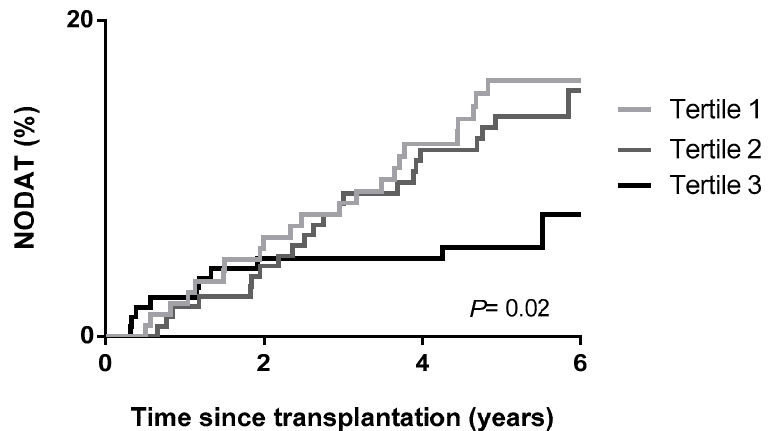
Figure 1. Kaplan–Meier curves for NODAT according to tertiles of plasma MDA concentration in RTR. Tertile 1: <2.15 µ mol/L; Tertile 2: 2.15–3.09 µ mol/L; Tertile 3: >3.09 µ mol/L. p value was calculated by Log-rank (Mantel cox) test. Table 2. Plasma MDA concentration and new-onset diabetes after transplantation (NODAT) in renal transplant recipients (RTR, n = 516).